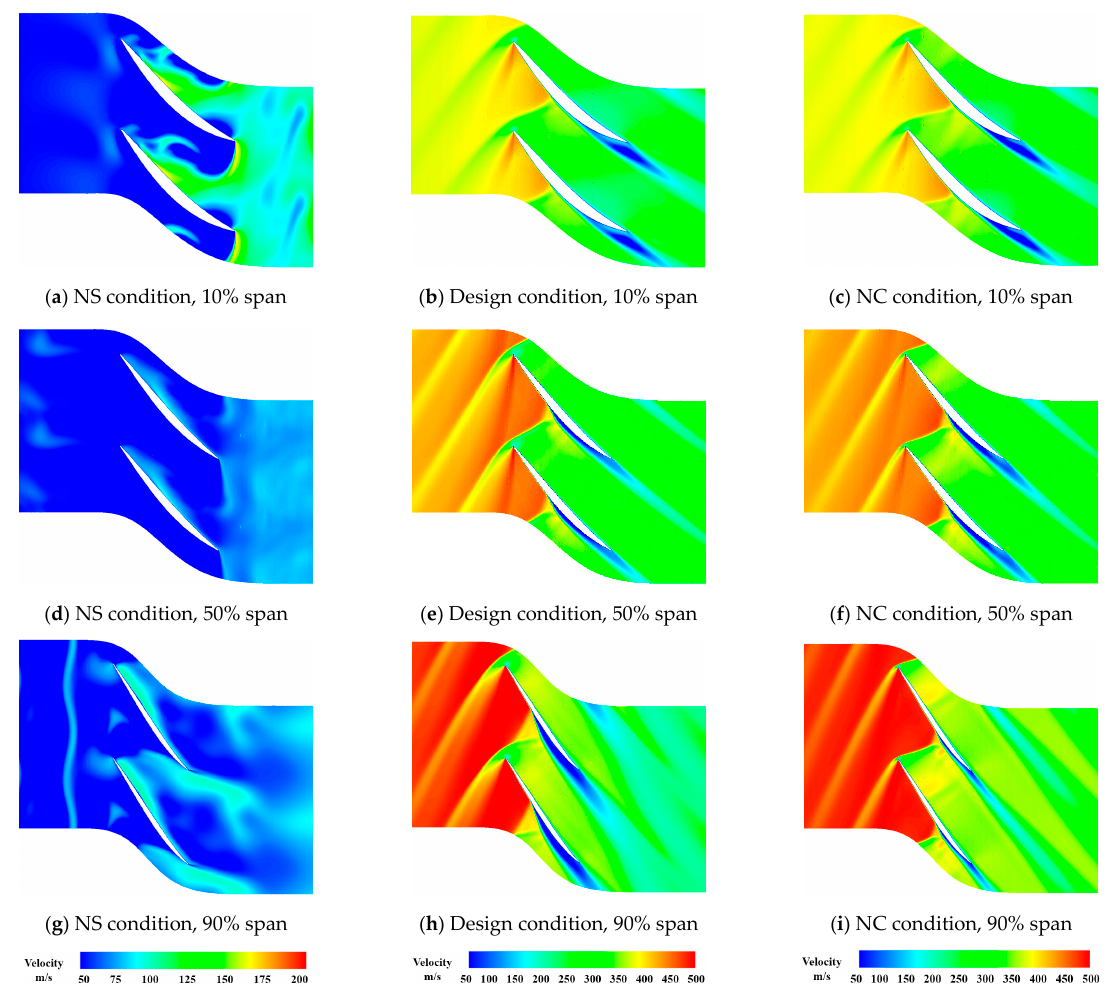
Figure 4. Velocity fields of the NASA rotor 37 at NS condition (first column), design condition (second column) and NC condition (third column).